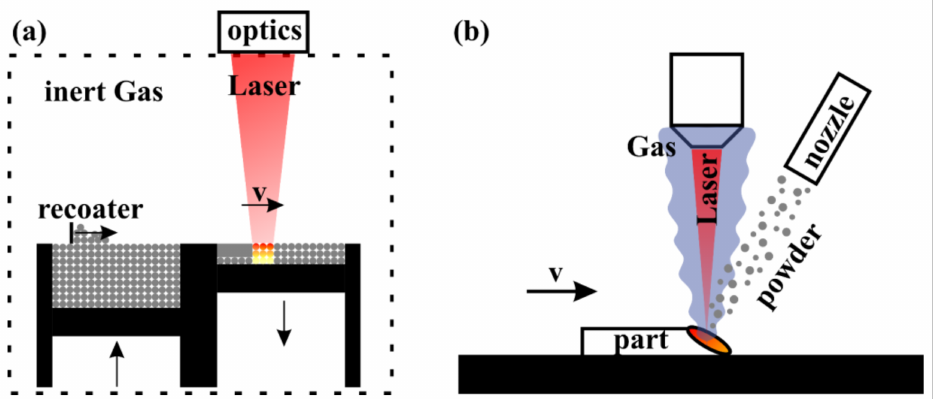
Figure 1. Simplified schematic images of the different laser-based additive manufacturing processes of ( a ) laser-powder bed fusion (adapted from [68]) and ( b ) powder-based laser metal deposition with a lateral injection nozzle (adapted from